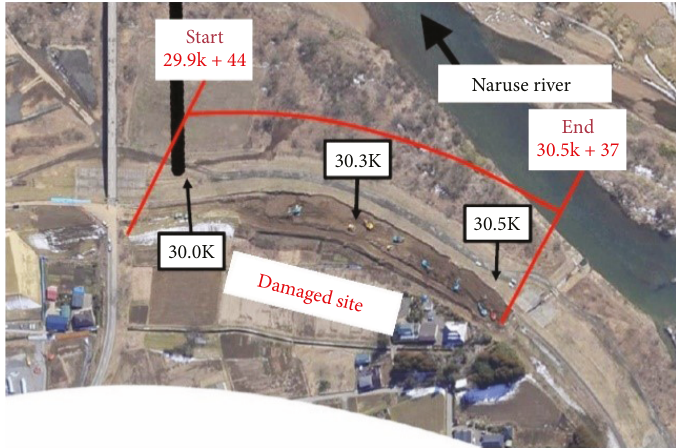
Figure 8: Location of the damaged site along the Naruse River [2].